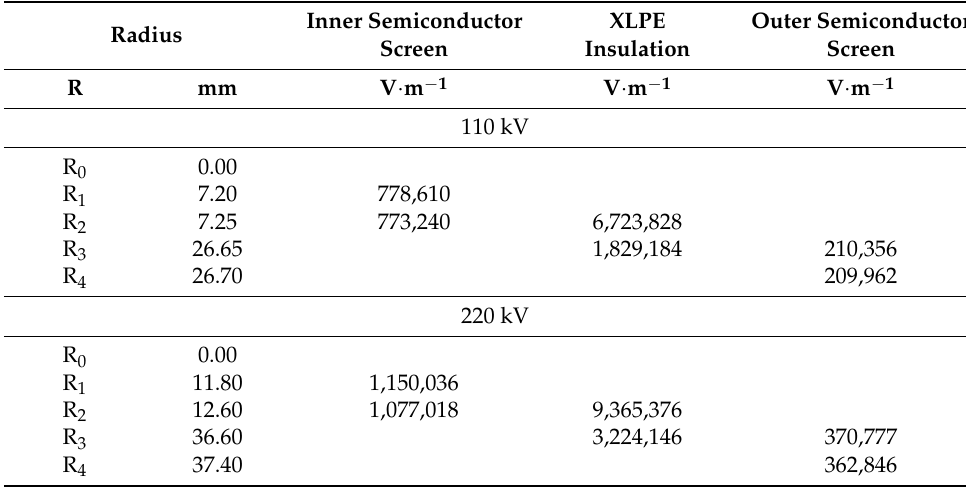
Table 6. Maximum E max and minimum E min values of electric field stress in semiconductor screens and XLPE insulation of high-voltage cables with 110, 220, 400, and 500 kV in case γ =